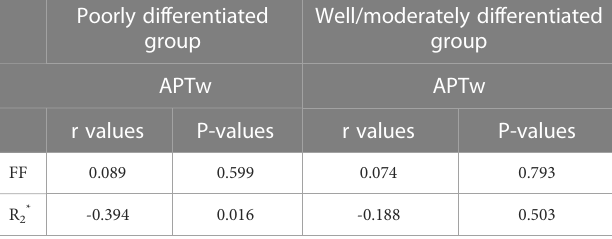
TABLE 7 Correlations between the APTw and mDixon-Quant parameters. Poorly differentiated